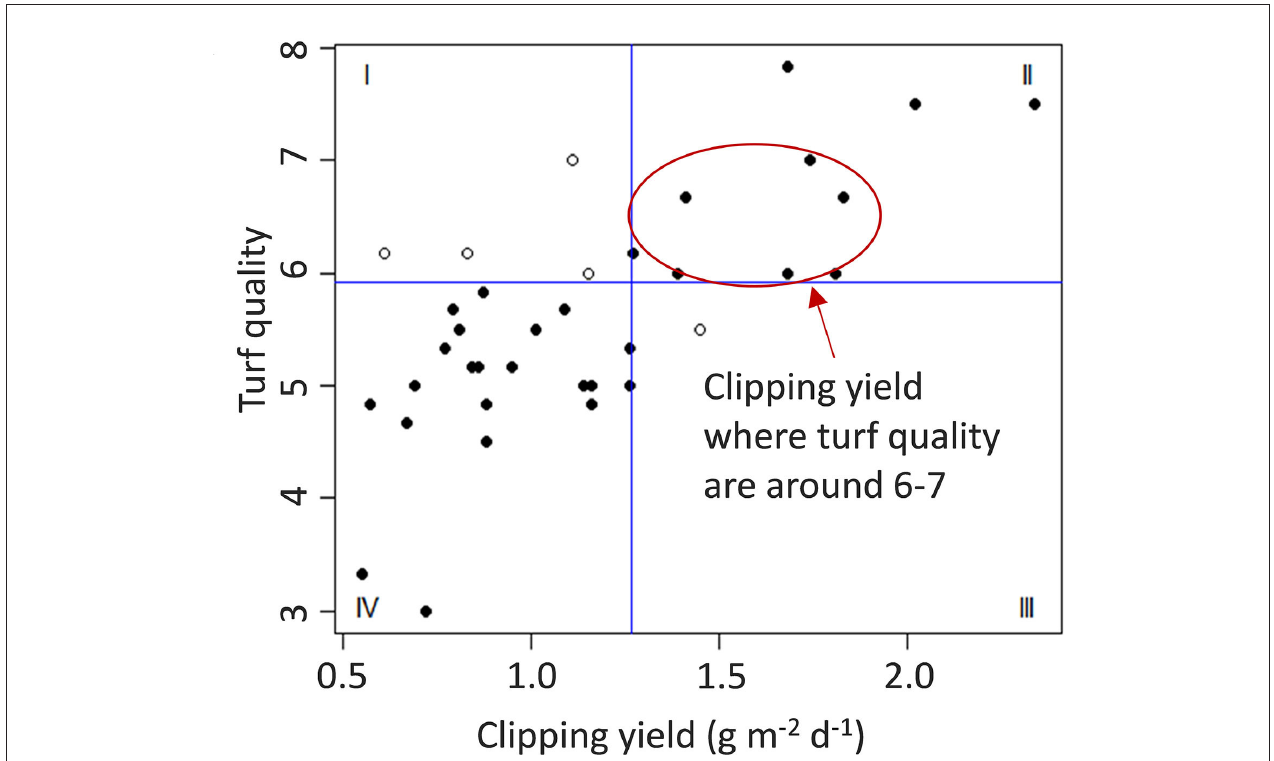
FIGURE 1 | Relationship between creeping bentgrass dry clipping yield and turf quality where the clipping and turf quality were collected in 2018 at the University of Wisconsin–Madison turfgrass research facility, Verona WI, USA. Turf quality was evaluated on a scale from 1 to 9 where 1 represents completely dead turf, 6 represents the minimally acceptable quality, and 9 represents ideal turfgrass